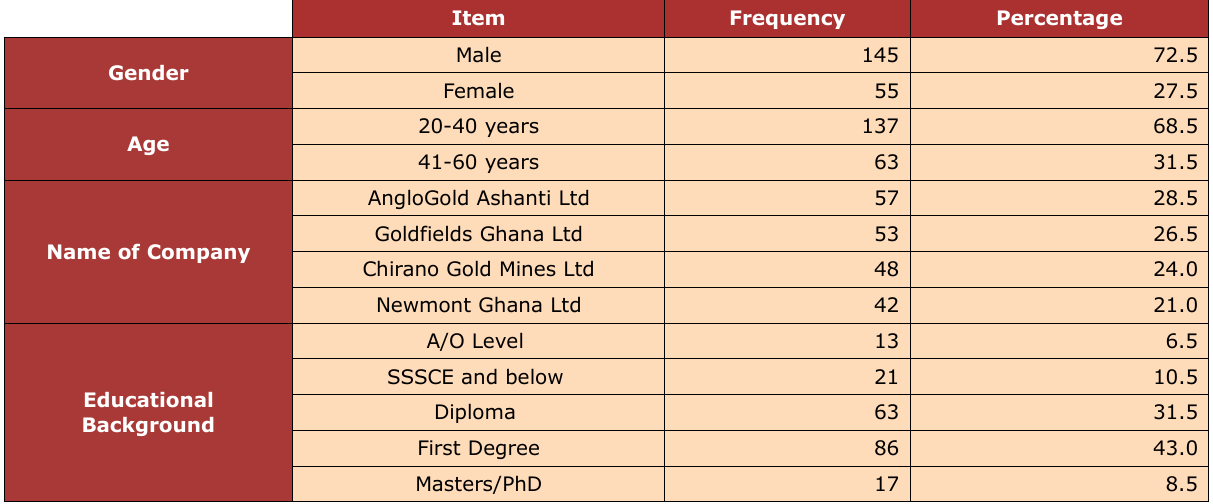
Table 4. Demographic